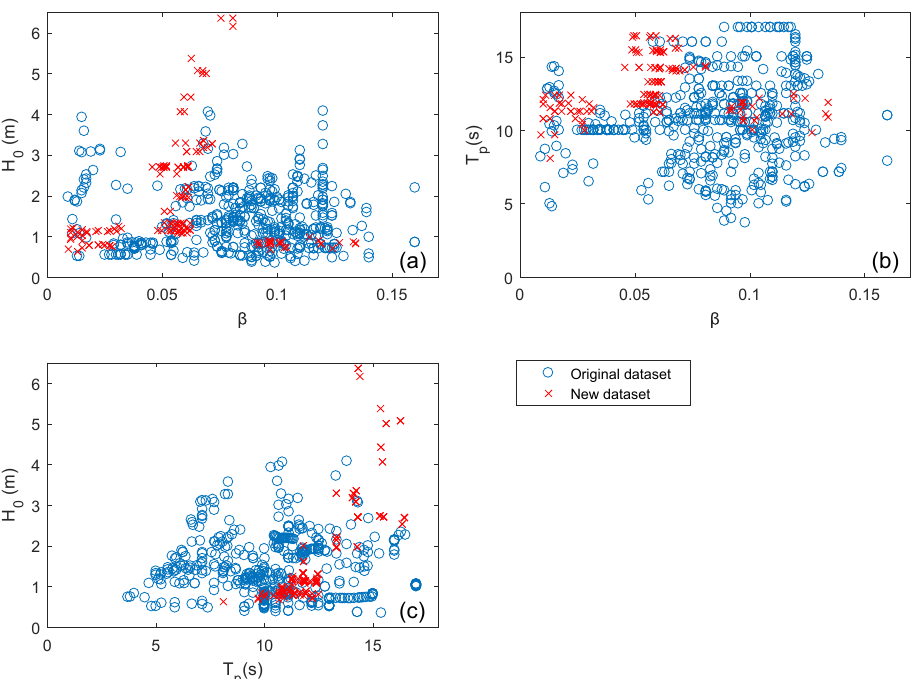
Figure 1. Environmental forcing conditions (blue circles: original data set, red crosses: new data set): (a) significant wave height versus beach slope, (b) wave peak period versus beach slope, (c) significant wave height versus wave peak period. Table 1. Summary of wave and beach parameters for the original and the new data sets, beach name and type (following the classification of Short (1999) based on Iribarren number (D stands for dissipative, I for intermediate and R for reflective); the last two rows indicate the range of parameters of the entire two data sets. Each experiment is associated with the citation where the measurements have been originally presented. If no reference is given, the citation is Stockdon et al